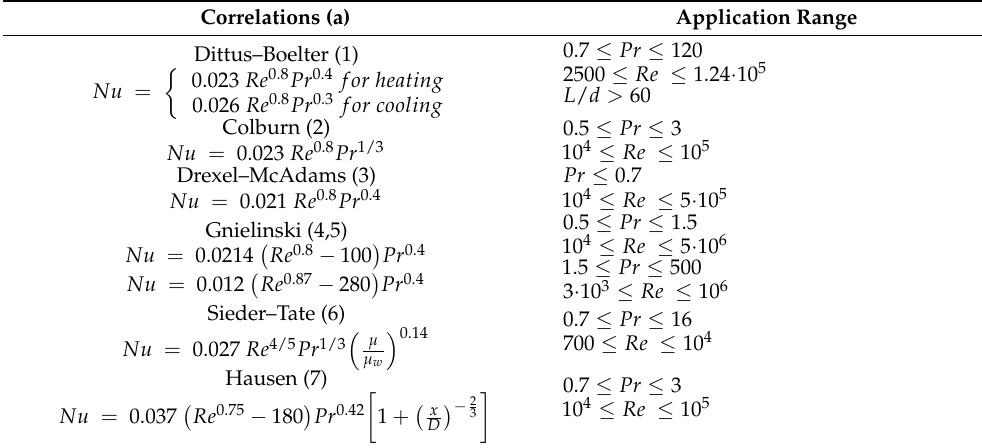
Table 1. Correlations for Nu number based only on Re and Pr numbers [23].